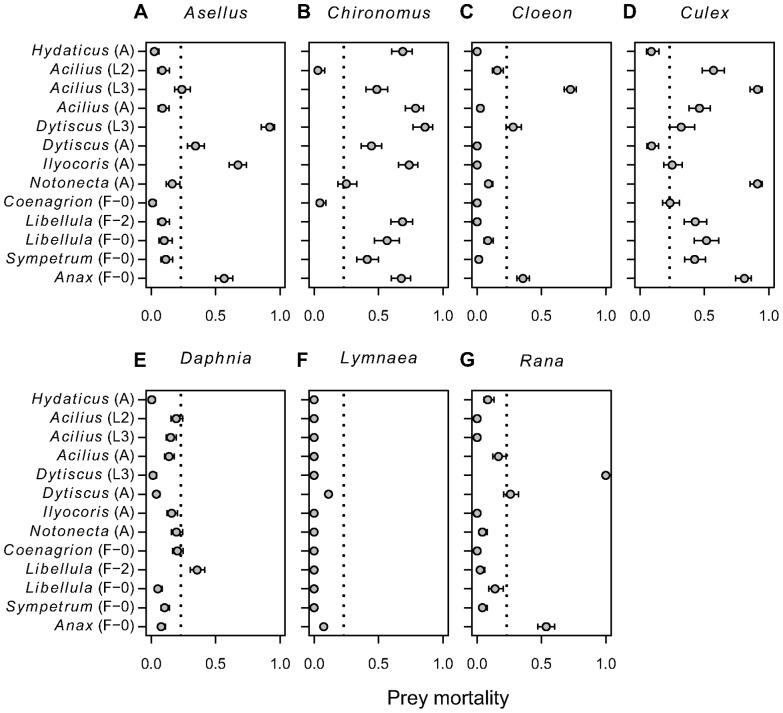
Mortality of individual prey species subjected to different predators.Prey mortality is expressed as proportion of individuals eaten during the experiment (mean ± SE). Dotted vertical lines represent the overall observed mortality averaged across all combinations of prey and predator species. Predator stage as in Table 1; predators ordered taxonomically as in Table 1 and Figure 1.